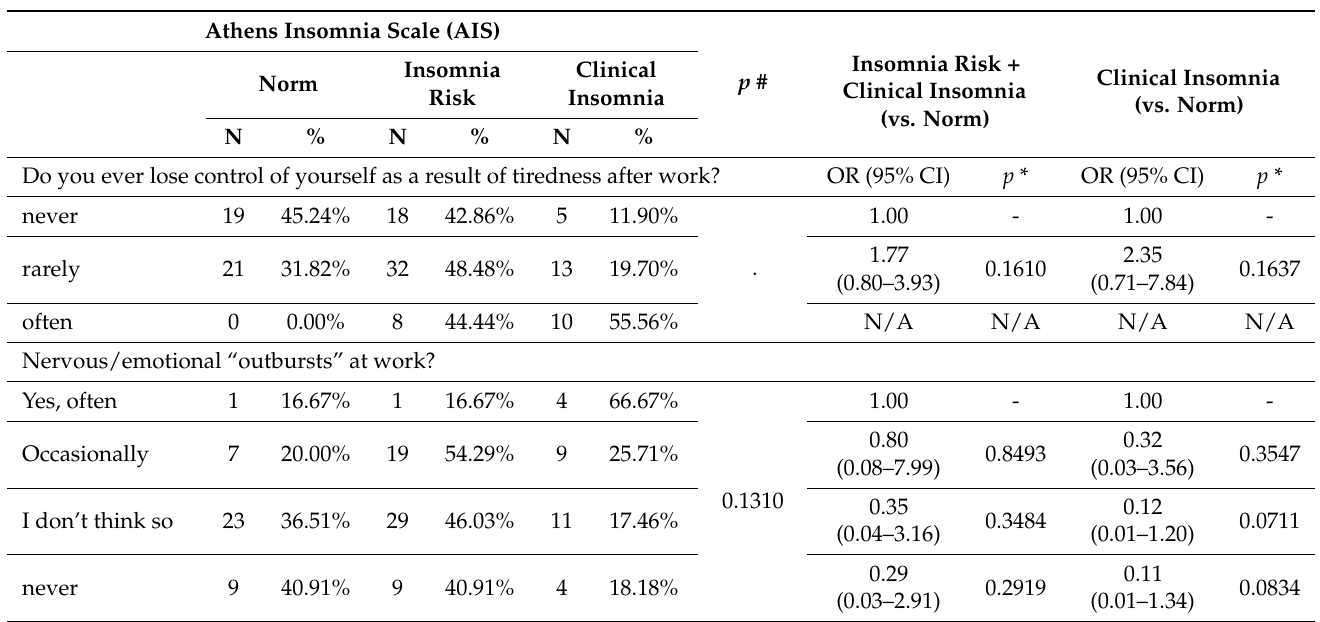
Table 3. The state of losing control over oneself and the occurrence of episodes of outbursts/nervous tension at